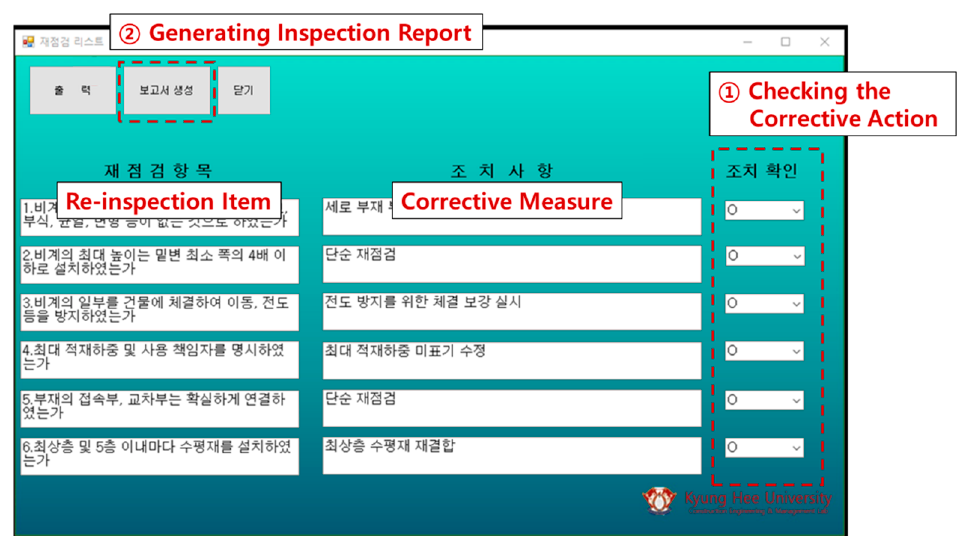
Figure 15. Quality inspection module—automated creation of the checklist.